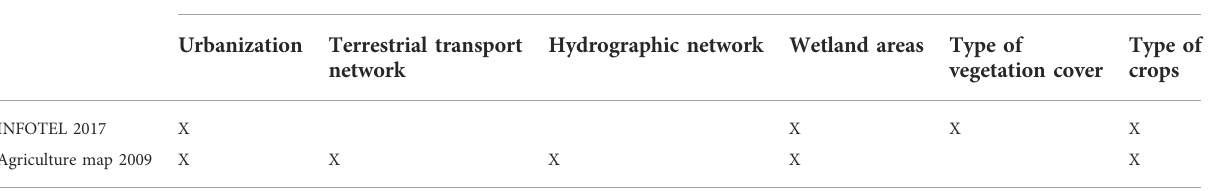
TABLE 1 Databases used in this study.